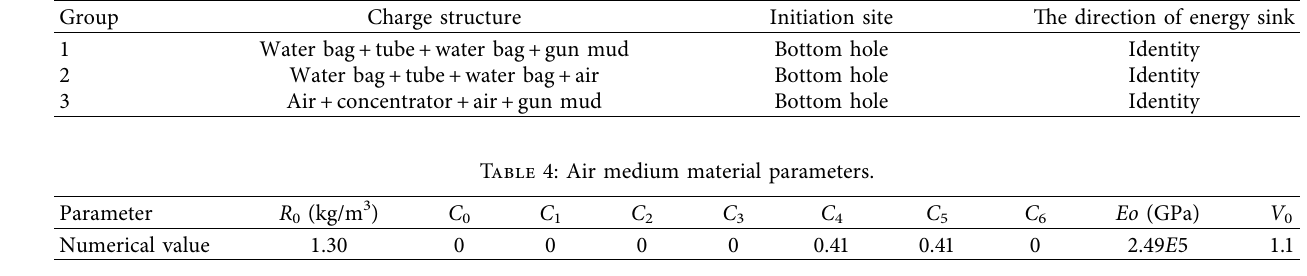
Table 3: Simulation charge scheme.